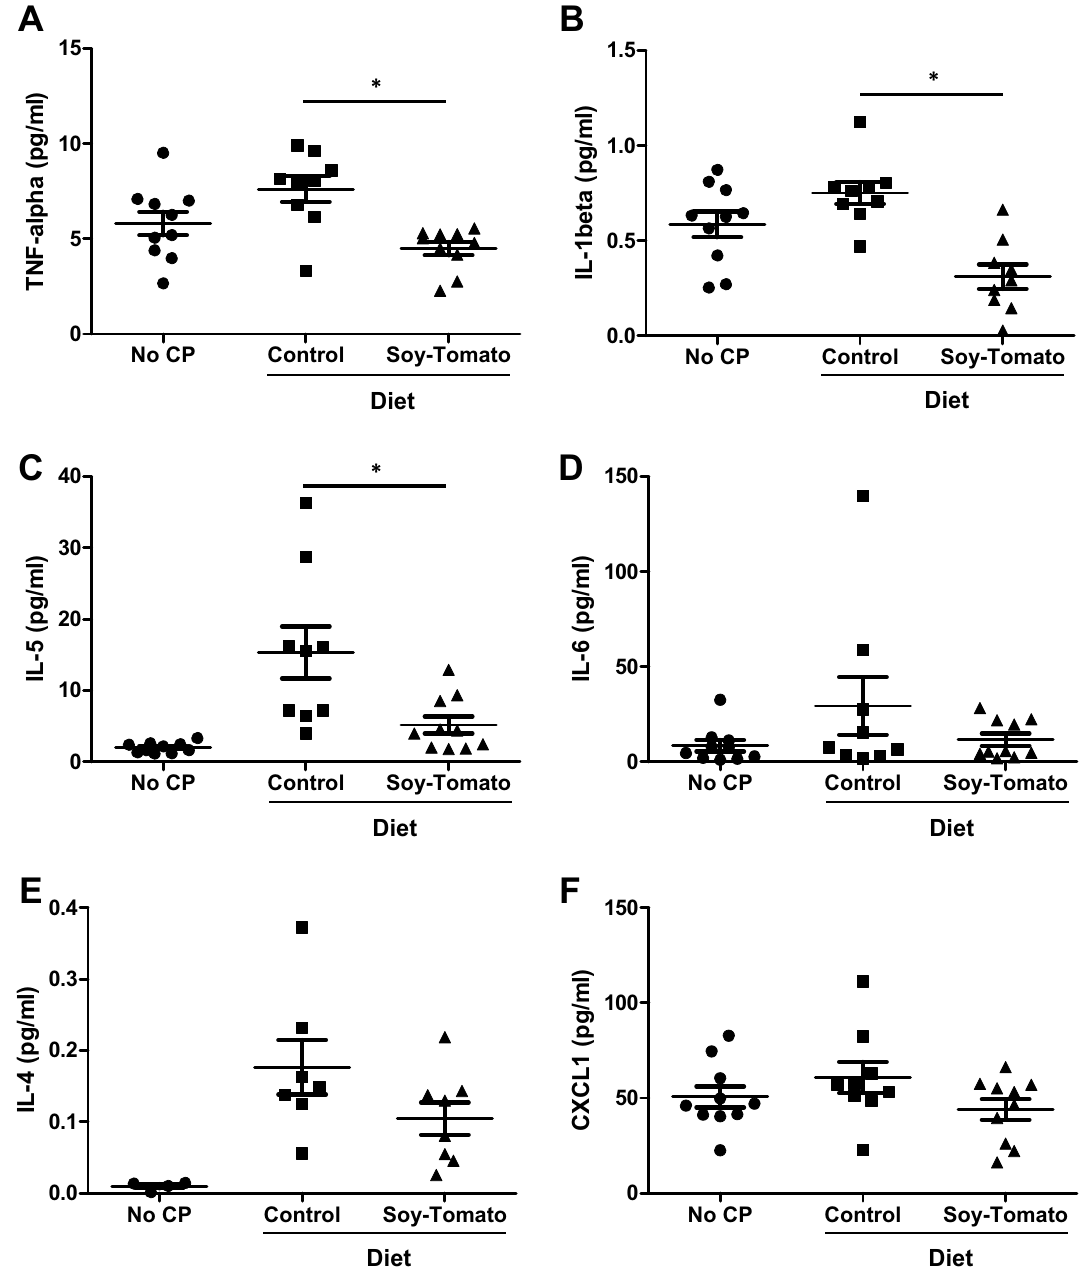
Figure 4. Reductions in systemic inflammatory cytokines in mice fed a soy-tomato diet. At the end of study, sera were collected from mice and analyzed by Meso Scale Discovery assay to determine systemic cytokine and chemokine expression. Serum levels of ( A ) TNF-alpha, ( B ) IL-1beta, ( C ) IL-5, ( D ) IL-6, ( E ) IL-4, and ( F ) CXCL1. N = 10 mice/group, * p <